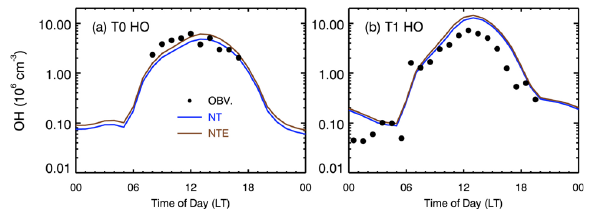
Fig. 10. OH diurnal cycles (a) at T0 and (b) at T1 averaged during the period from 24 to 29 March 2006. Black dots: measurements; blue line: the NT-SOA model; brown line: the NTE-SOA model (without OH